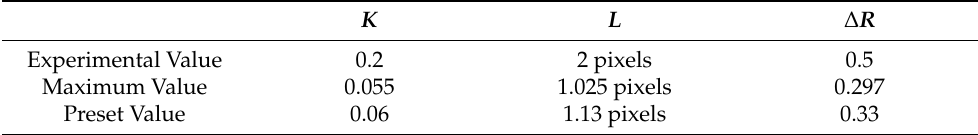
Table 1. The size of each parameter